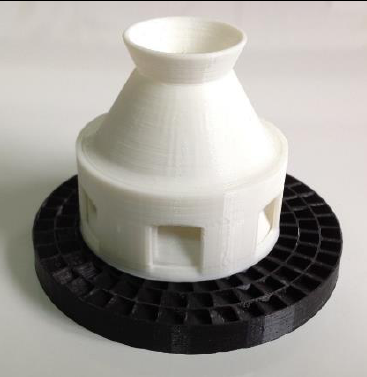
Figure 14. An impeller, nozzle block, and control sleeve (diaphragm) prototype together with a disk axial turbine prototype. The turbine developed and presented in this article is similar to a partial admission turbine [12-14]. As a rule, a turbine is called a partial admission one when the nozzle block has blades only on the part of its circumference; in this connection, the gas is supplied to the impeller only within this part of the circumference. Figure 15 shows a typical schematic diagram of a partial admission turbine.